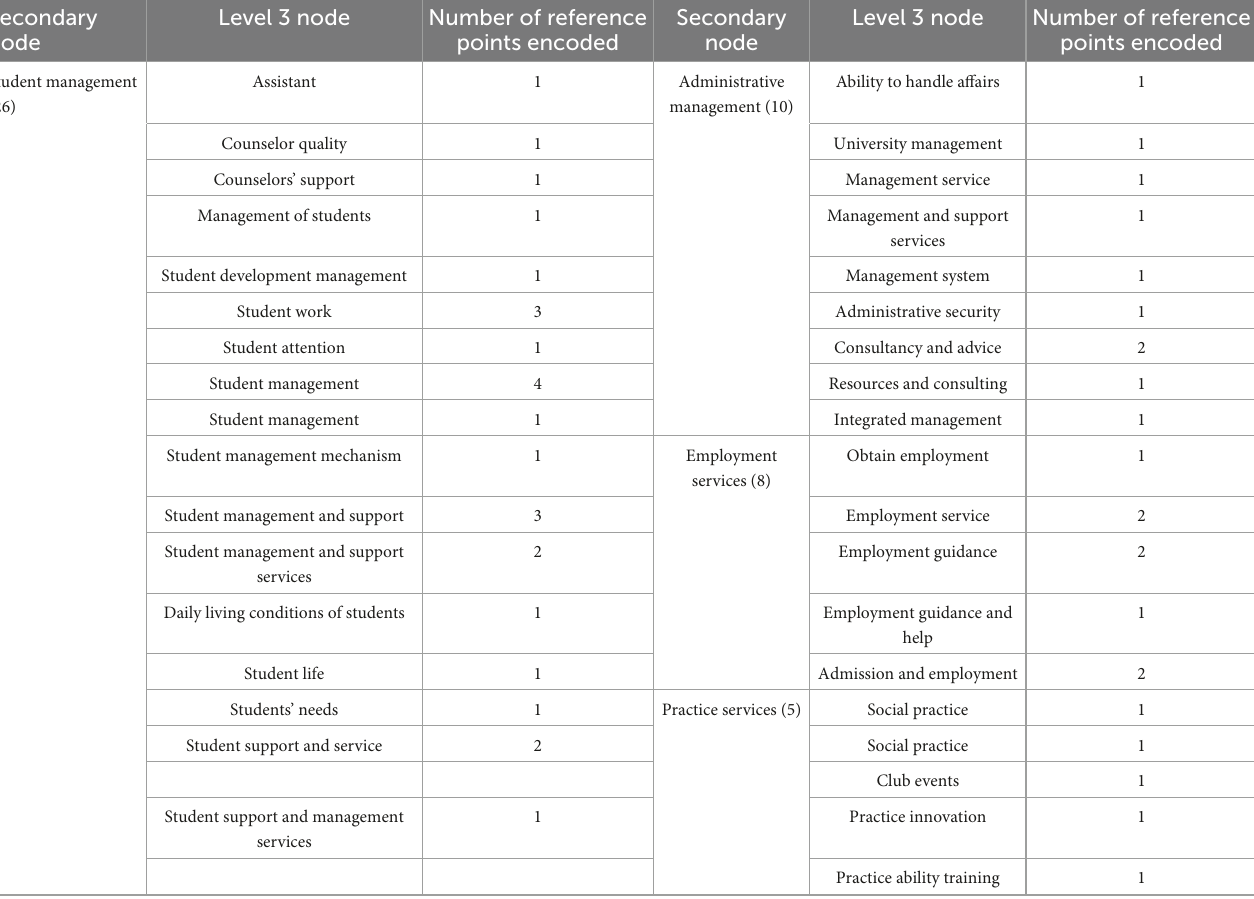
TABLE 4 Nodes and coding reference points in organizational management. Secondary node